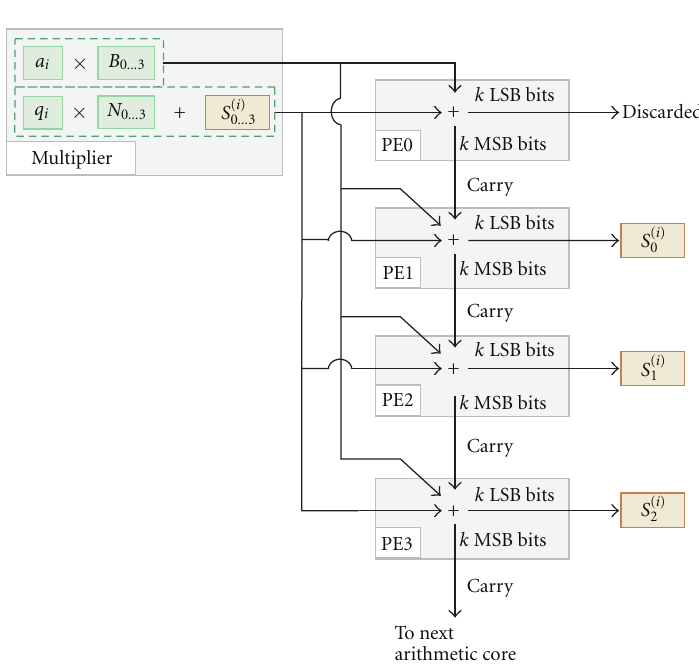
Figure 8: Arithmetic operations performed in arithmetic core